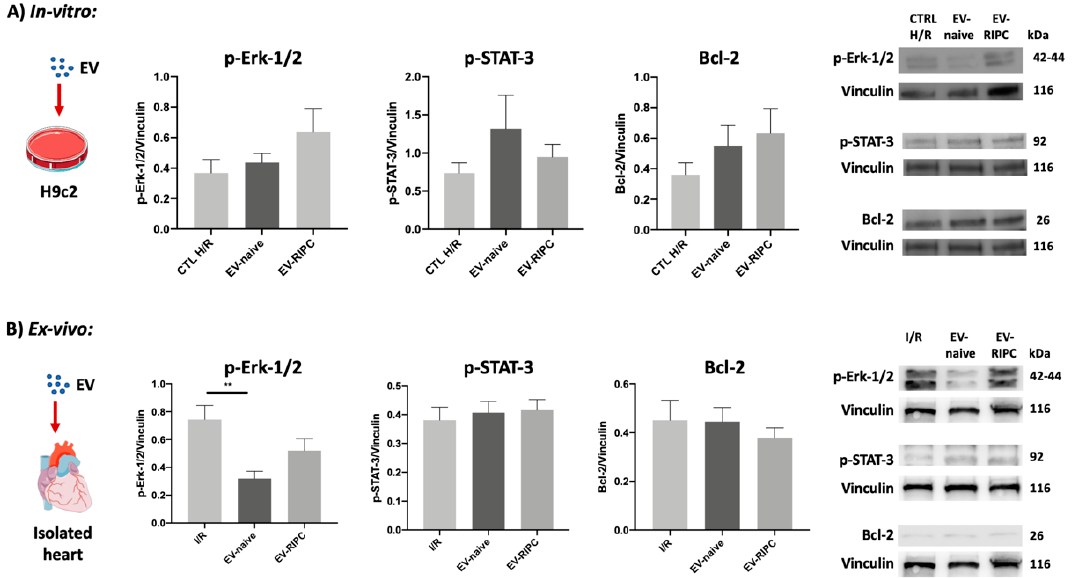
Figure 4. Effects of EVs on canonical cardio-protective pathways. ( A ) Representative Western blot analysis and histograms of cells subjected to H/R protocol, after EV treatment (n = 30). ( B ) Representative Western blot analysis and histograms of myocardial tissues subjected to I/R protocol, after EV treatment (n = 30). p-Erk-1/2, p-STAT-3 and Bcl-2 expression were normalized to vinculin (** p = 0.002).